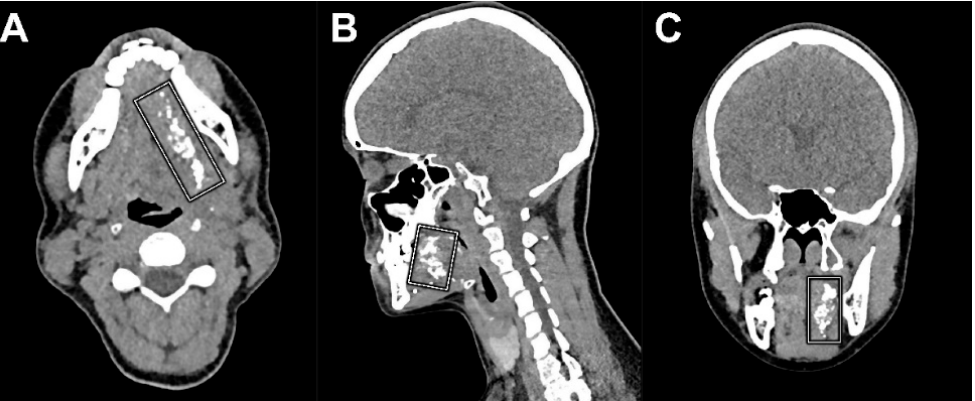
Figure 6. CT images as part of the FDG-PET/CT acquired 13 days following peritumoral administra- tion of Lipiodol ® (patient 6) clearly depicts remains of Lipiodol ® located around the initial primary tumor site (white squares). ( A ) Axial plane, ( B ) coronal plane, and ( C ) sagittal plane.